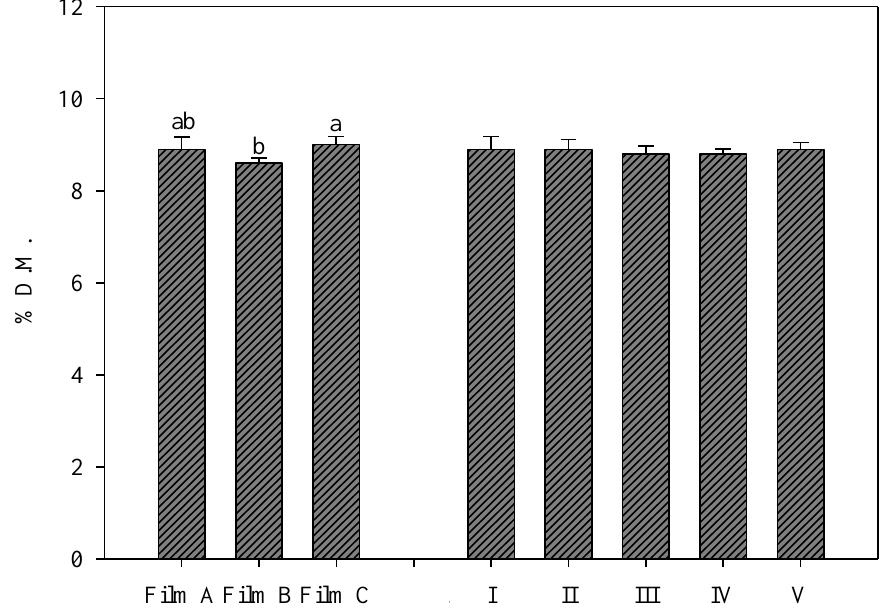
Figure 1. Dry matter percentage (% w / w ) in wild rocket leaves as affected by greenhouse cover film (Film A: diffused light film; Film B: clear film; Film C: diffused light film with UV-B window). Vertical bars indicate standard error; different letters indicate significant differences according to Tukey’s test ( p ≤ 0.05); ns indicates no significant differences.